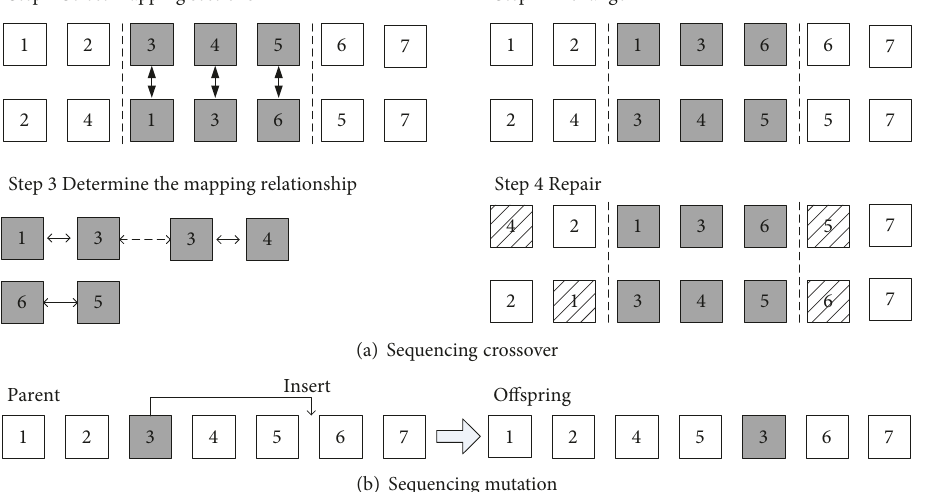
Figure 6: Example of sequencing